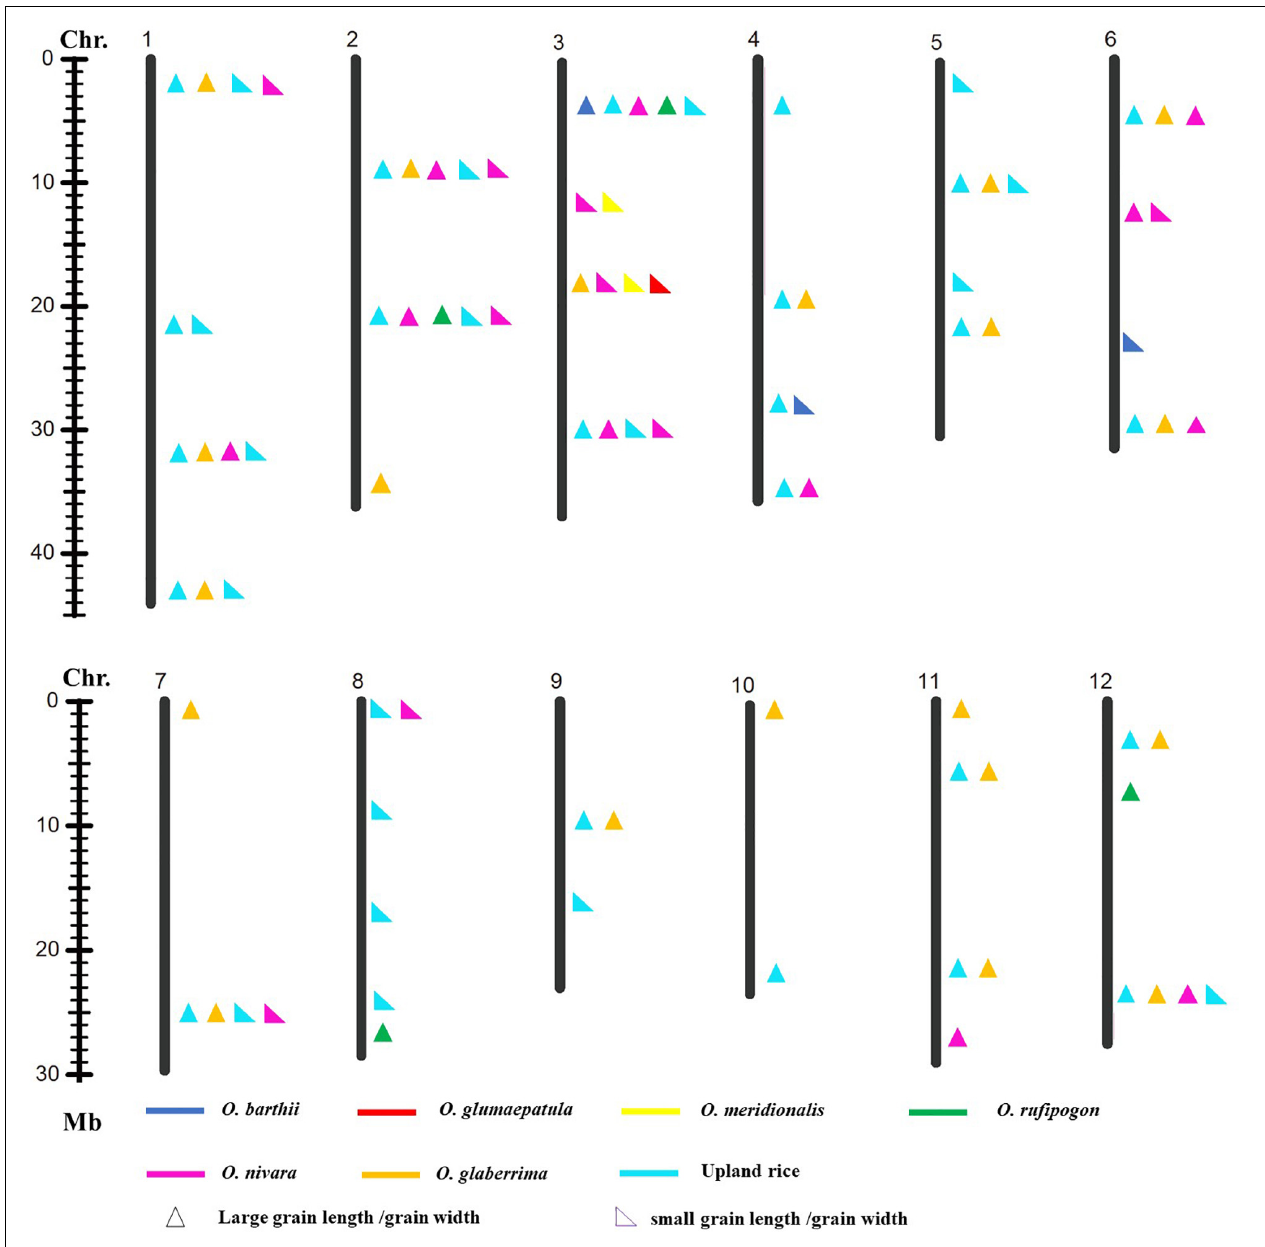
FIGURE 5 | Allelic variation linking with the RLW was detected from the different